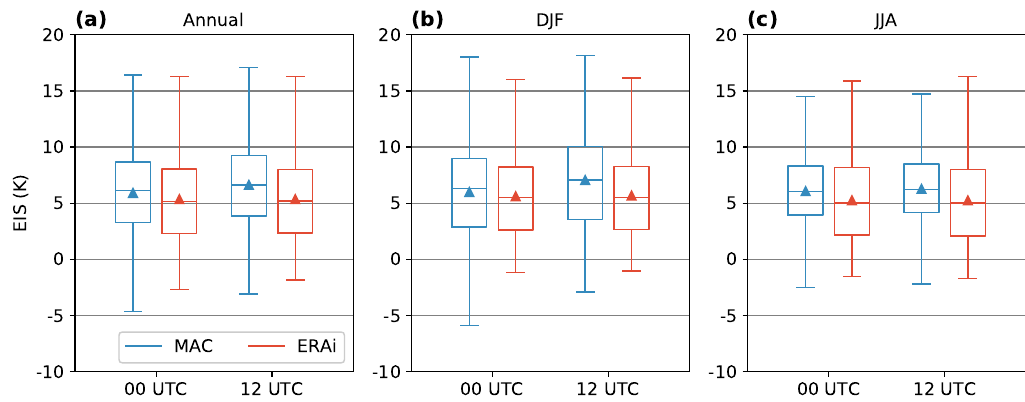
Figure 5. Estimated inversion strength (EIS) parameter for MAC observations and ERA-Interim profiles. ( a ) Annual, ( b ) summer (DJF), and ( c ) winter (JJA). The median values are shown as horizontal lines and the mean values as triangles. Boxes indicate the interquartile range (25th to 75th percentiles) and the whiskers extend to ± 2 σ of the standard normal